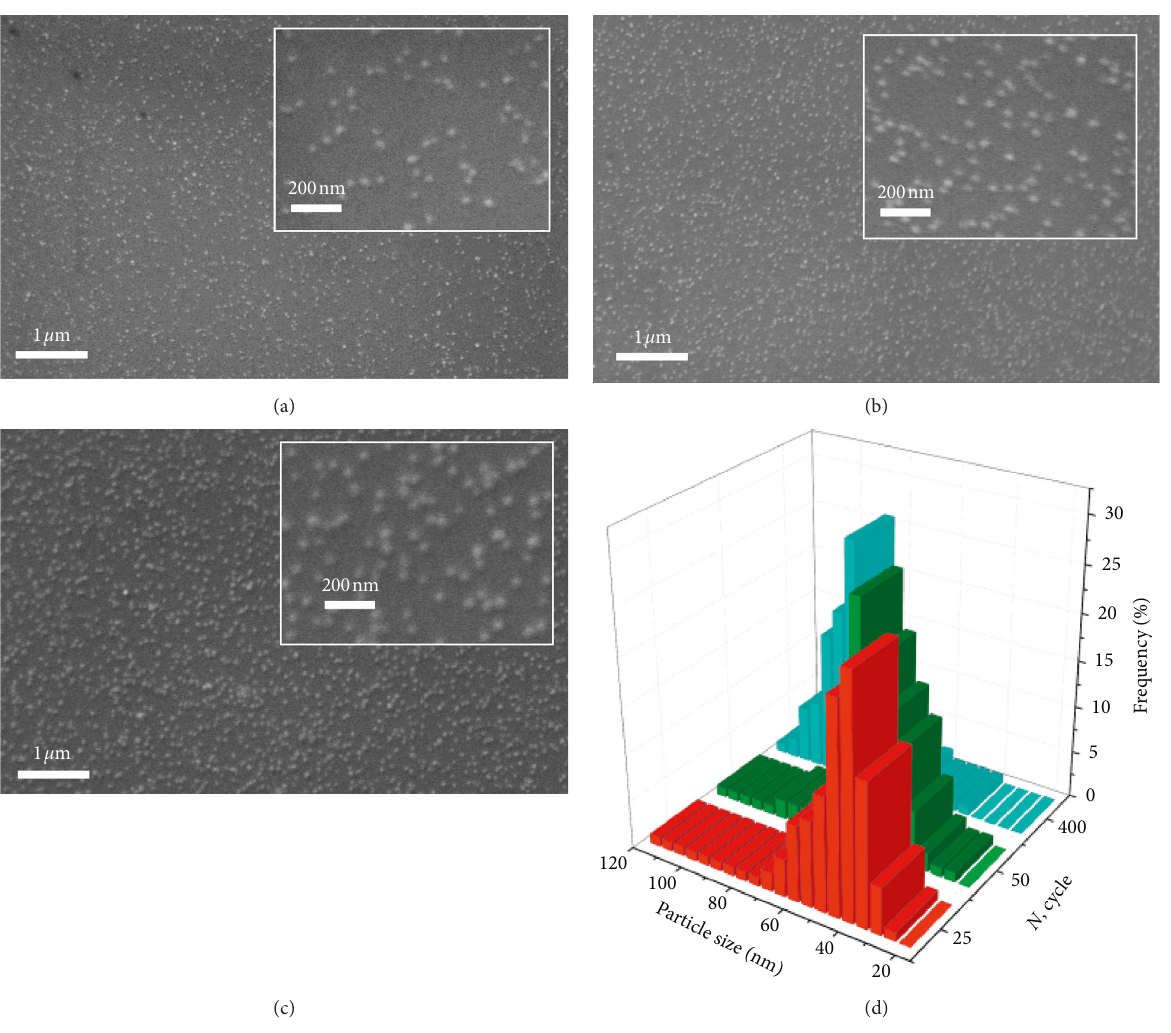
Figure 3: SEM images of PdNPs on the silicon surface obtained by electrolysis in a solution containing 4mM of Pd(NO Bu 4 NClO 4 , and DMSO at E cathode �− 2.0V for 25 (a), 50 (b), and 400 (c) cycles and the size distribution histograms of PdNPs